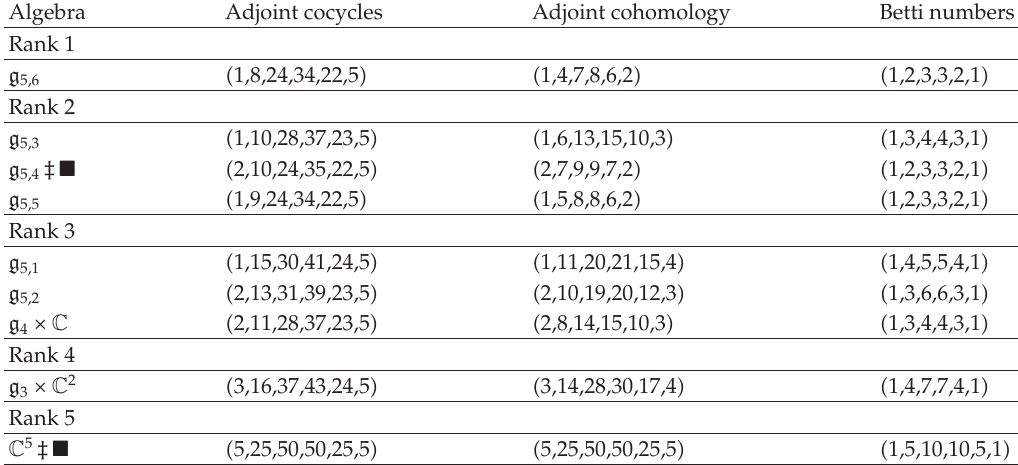
Table 12: Cohomology table for NLAs of dimension 5.